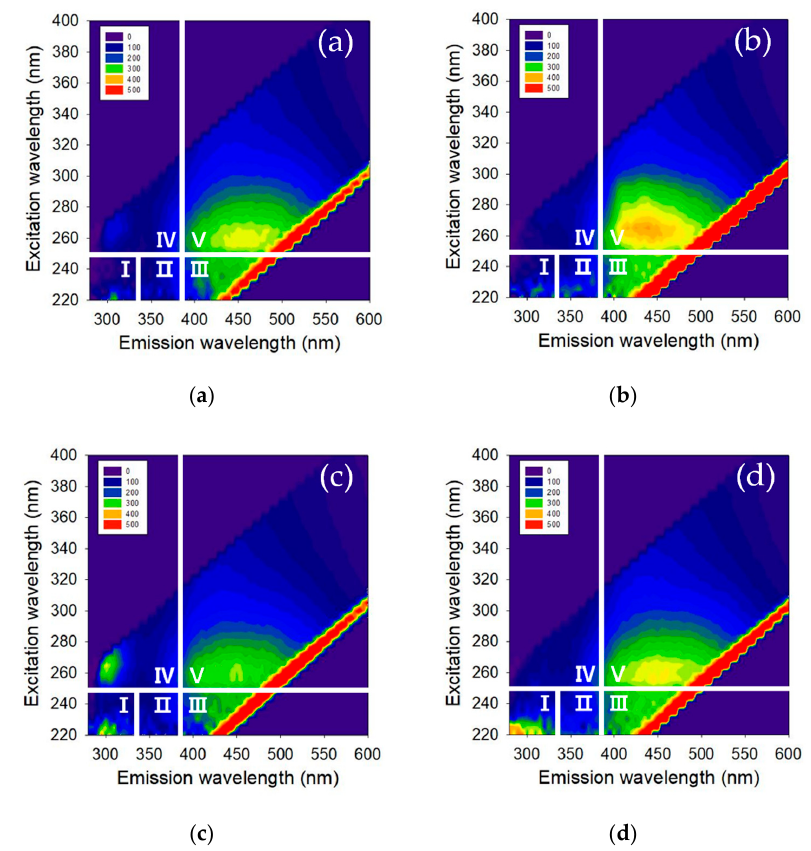
Figure 3. Excitation emission matrix for coal degradation intermediates: ( a ) control, ( b ) AC, ( c ) AE33, and ( d )